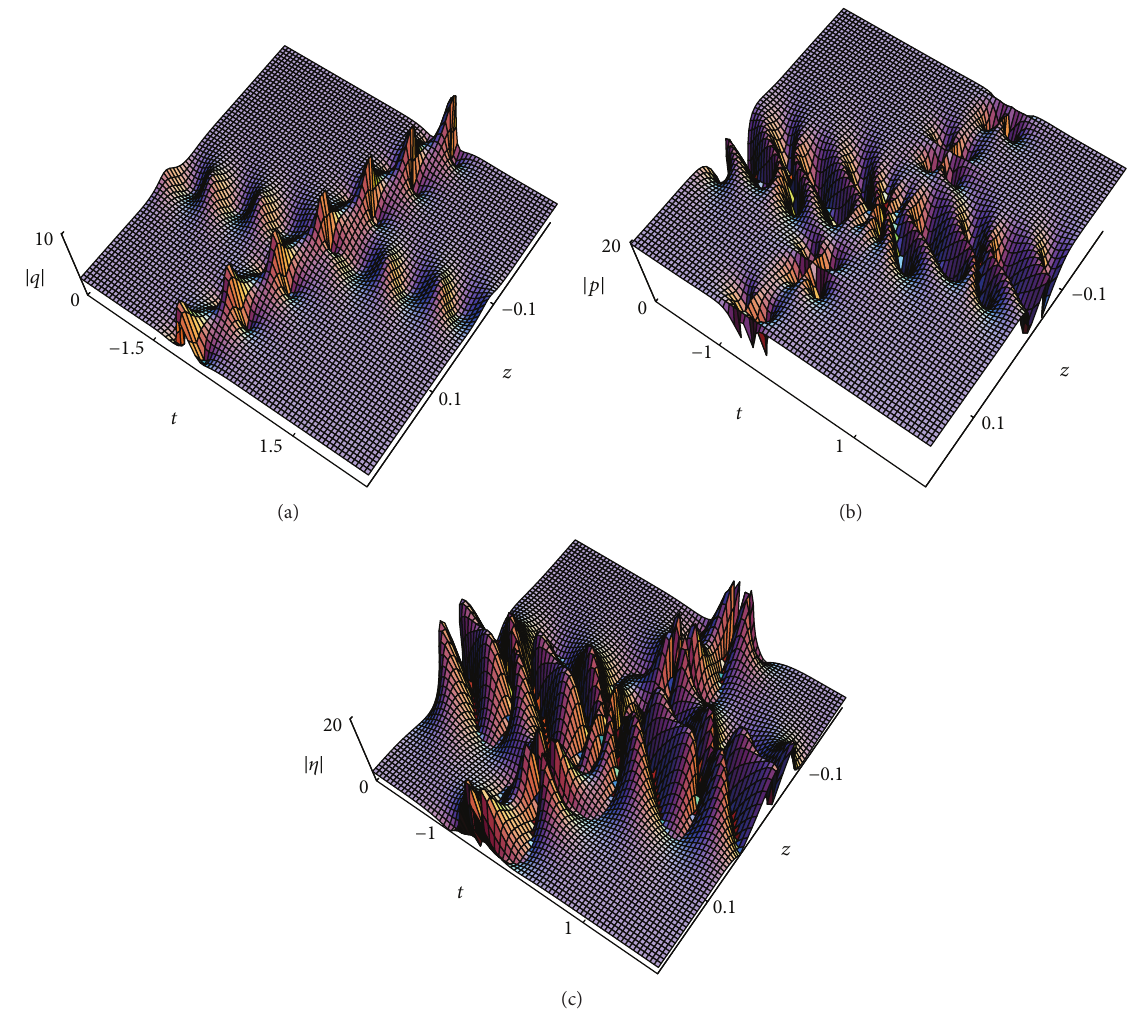
Figure 7: The parameters adopted here are 𝜆 1 = 𝑖 , 𝜆 2 = 4𝑖 , 𝑞 𝑐 = 3 , 𝜔 𝑐 = 2 , 𝜅 𝑐 = 1 , 𝜔 = 0.5 , and 𝜏 = 0.1 .